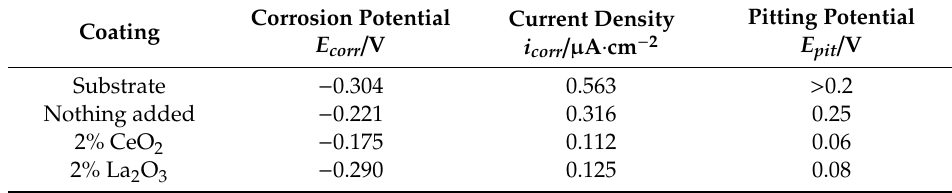
Figure 6. Polarization curves of 316L stainless steel before and after rare earth oxide-modified laser cladding in 3.5 wt % NaCl solution. Table 2. Electrochemical parameters of samples in 3.5 wt % NaCl solution under di ff erent conditions.